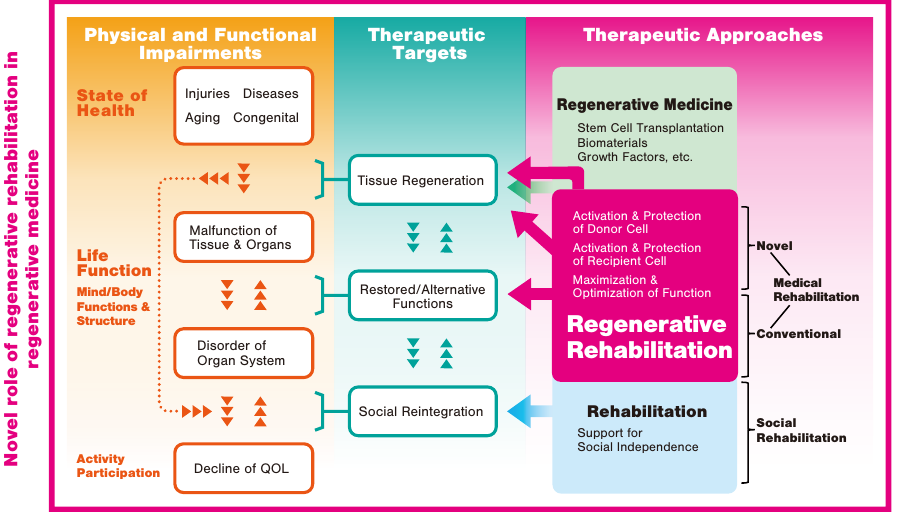
Figure 3. Schematic diagram of regenerative rehabilitation. Regenerative rehabilitation will play a novel role in regenerative medicine. QOL: quality of